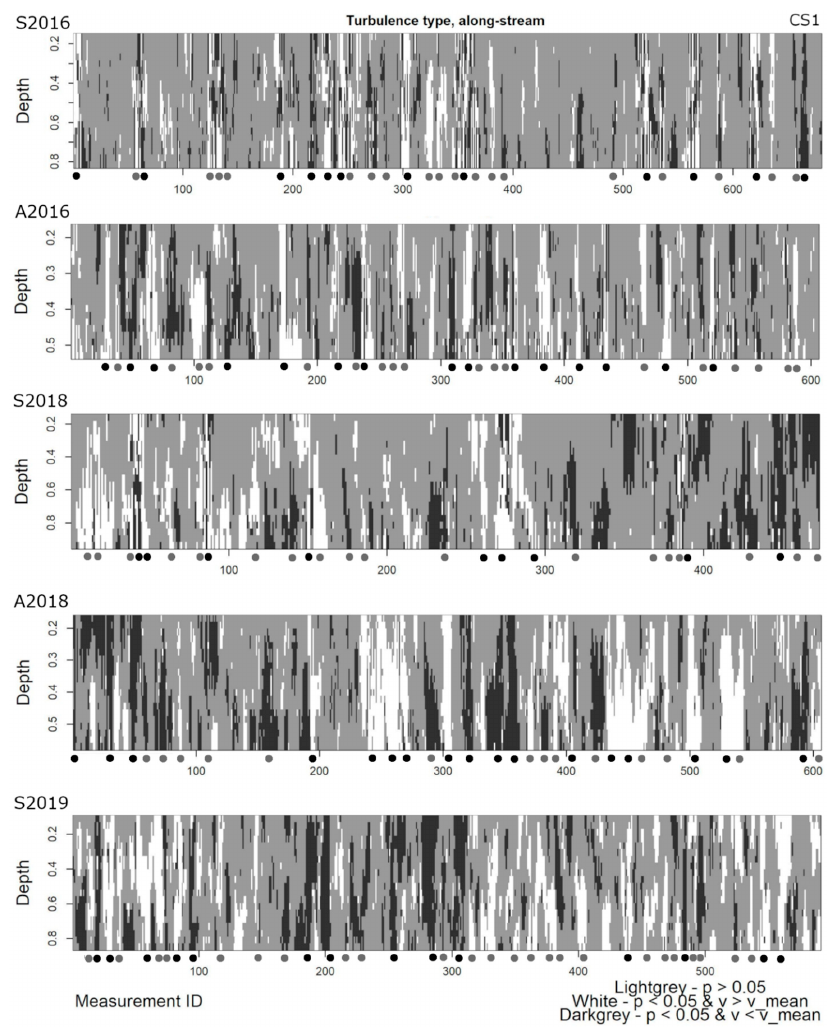
Figure 6. The results of the LISA analysis of open-channel conditions at CS1 based on streamwise velocity. The S2017 results can be seen from Figure 4. Measurement ID means the sample numbers ( n ), and therefore also represents seconds. The black dots indicate the occurrence times of statistically significant strong high and low flow wedges reaching from the surface to the riverbed. The grey dots indicate the times when there is weaker wedge (i.e., a cluster has broken with a few cells within the vertical water column).